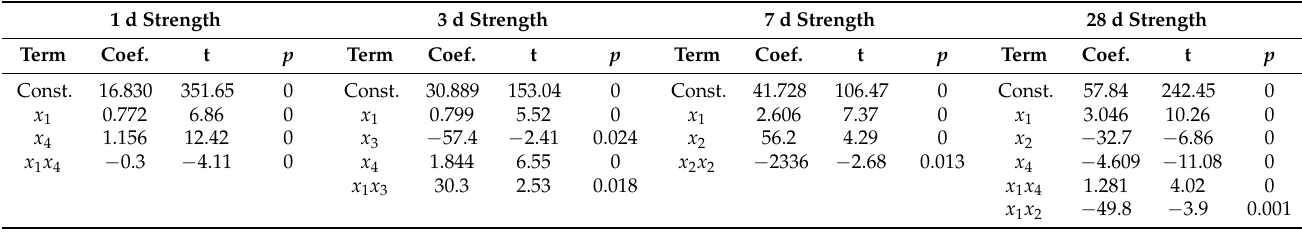
Table 4. ANOVA of the final CCFD models for compressive strength of